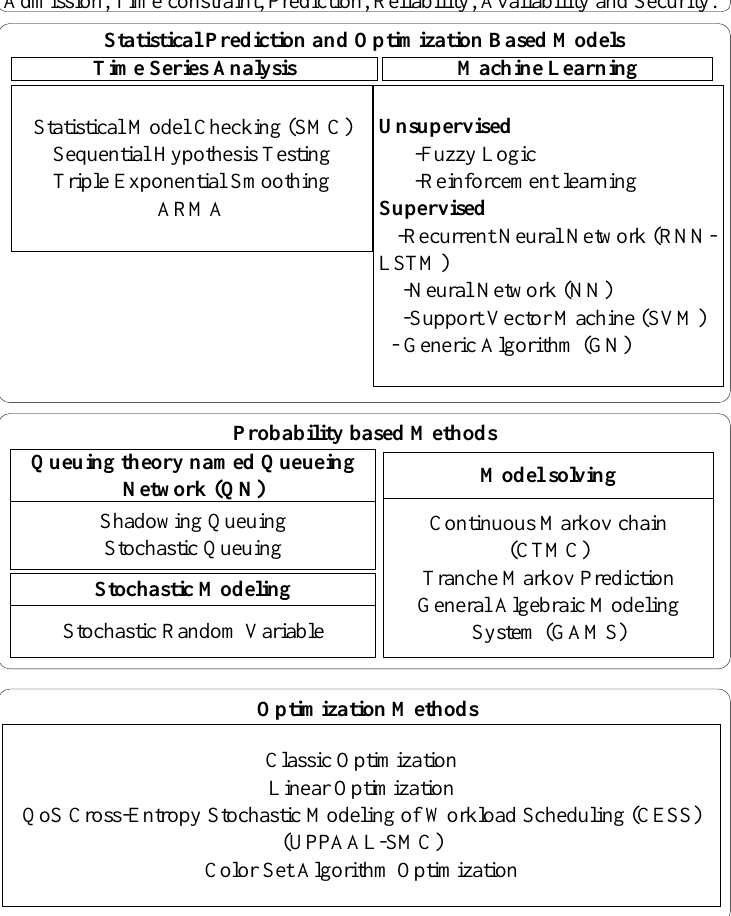
Figure 1. Review of Elastic Resources Scaling Methods and